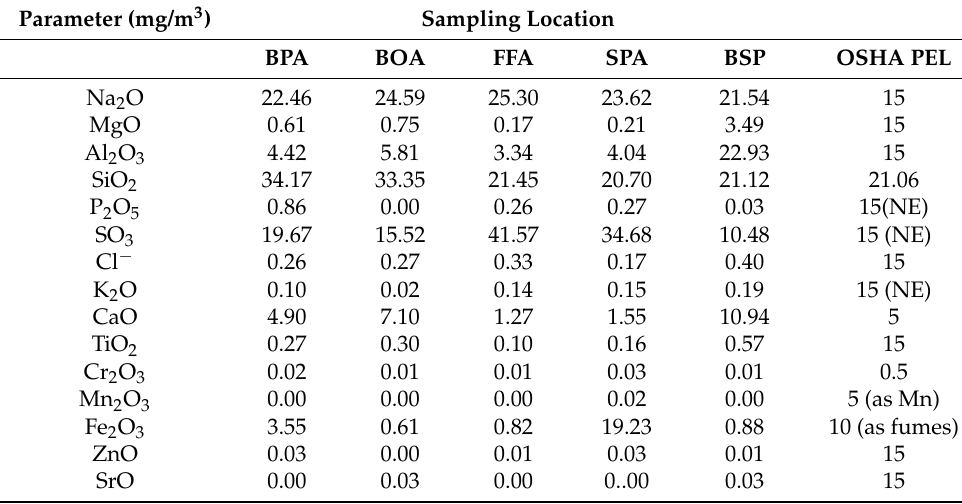
Table 6. Particulate Matter Characterization 8 h